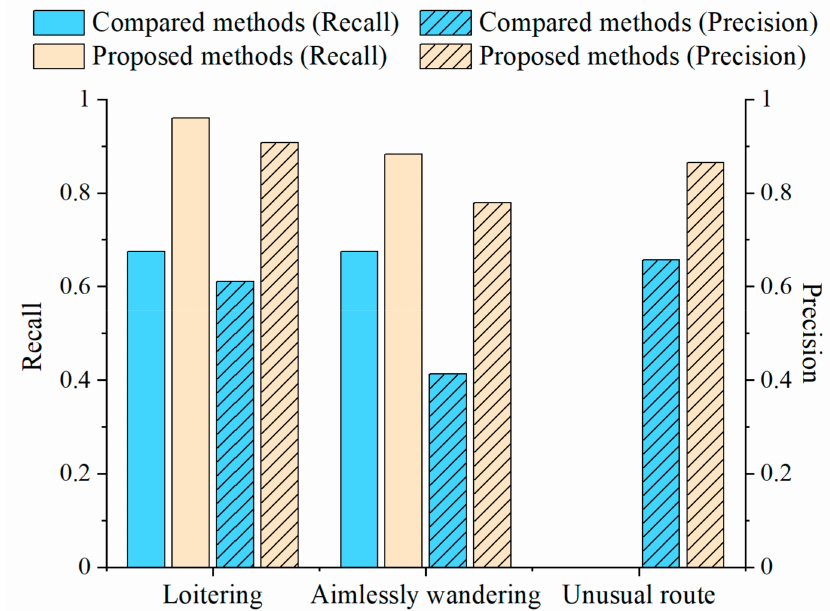
Figure 8. Comparison of the accuracy of different methods in suspicious behavior detection. The compared methods include the method that was proposed by Wu et al. [17] for loitering detection, θ _WD [47] for aimlessly wandering detection, and LOF [48] for unusual route detection.